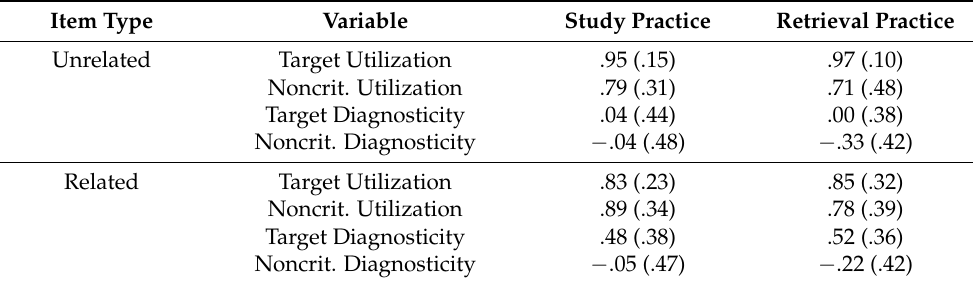
Table 8. Mean utilization and diagnosticity of target retrieval and noncriterial